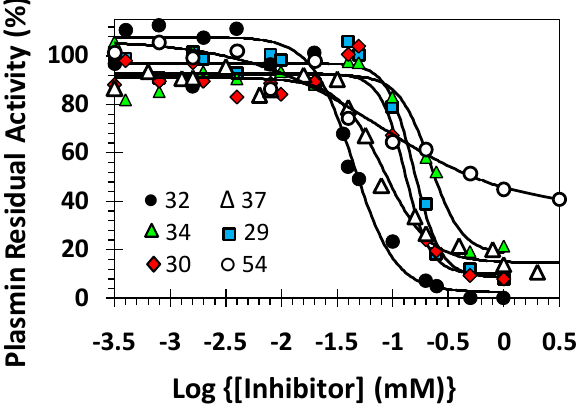
Figure 2. Initial screening of the 55 sulfated small molecules against human plasmin. Screening was performed in 50 mM Tris-HCl buffer at 150 mM NaCl, pH 7.4, and 37 °C using the corresponding chromogenic substrate hydrolysis assay in the presence of 400 μM inhibitor (n ≥ 2). The error bars represents one standard deviation.